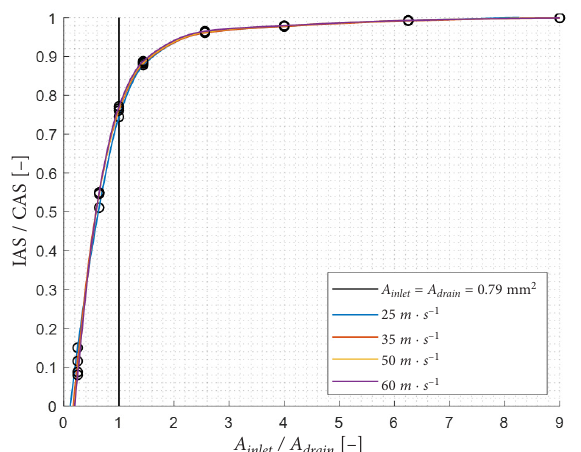
Figure 5. Gradual blocking curve IAS / CAS ratio A inlet / A drain ratio for a pitot tube with 1 mm drain hole diameter